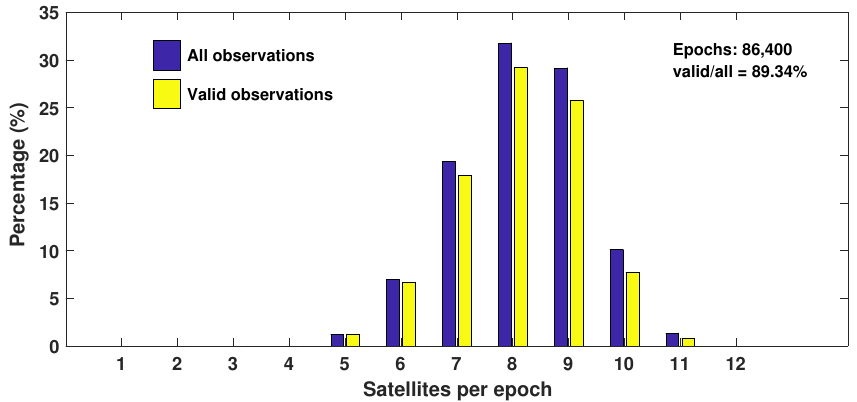
Figure 3. Relationship between the number of observed satellites and the ratio of epochs observed at a certain number of satellites to total epochs for DOY 339, 2016. The blue bar represents the “All observations”, and the yellow bar represents the “Valid observations”.